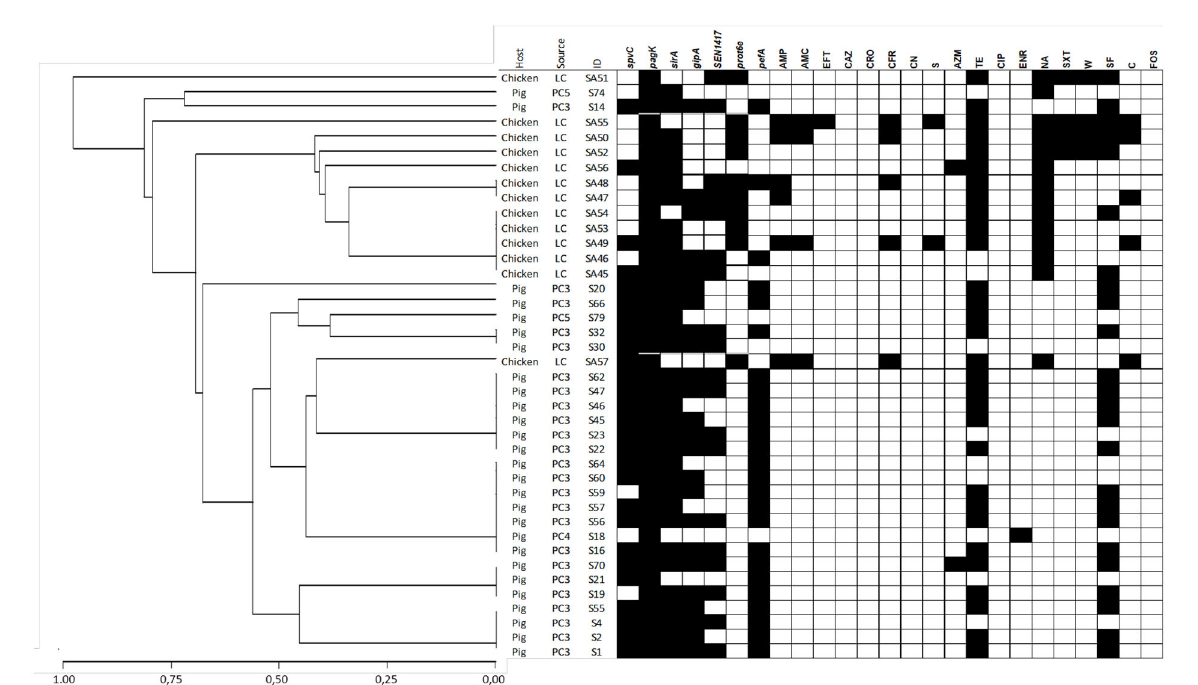
FIGURE2 Dendrogram showing genetic similarities (%) among S. Typhimurium isolates analyzed using multiplex PCR. Detection of virulence-associated genes and antimicrobial resistance phenotypes are depicted as black squares when present. The dendrogram was constructed using a hierarchical clustering, using the average linkage method and Jaccard’s